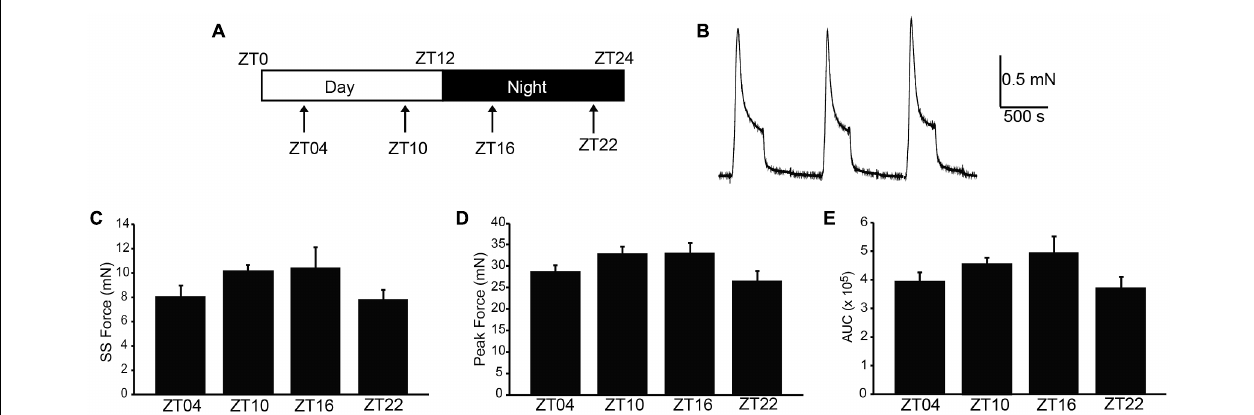
FIGURE 1 | High K + -induced excitation–contraction responses are similar across the circadian cycle in isolated UBSM strips. (A) Schematic of the circadian cycle and four time points examined in this study. Mice are nocturnal, resting during the daytime light period, zeitgeber time (ZT) 0–12, and being active at night during the nighttime dark period,